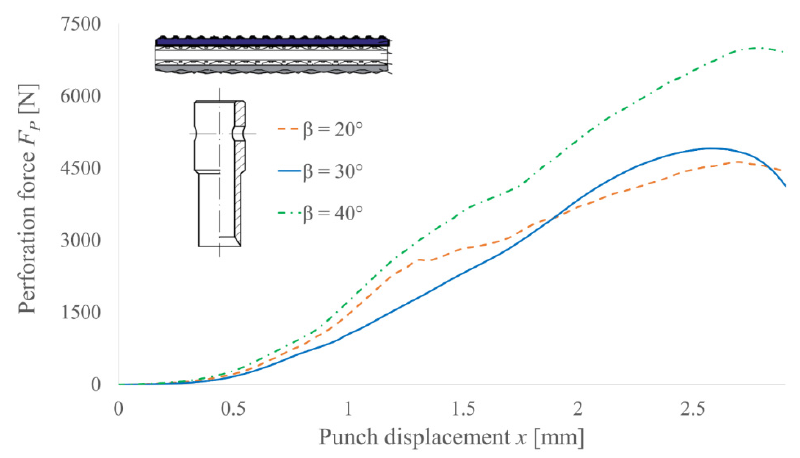
Figure 12. Experimental results of the perforation force measurement for PI punches with diameter d = 10 mm and various angles of the blade β for TFL10S belt.